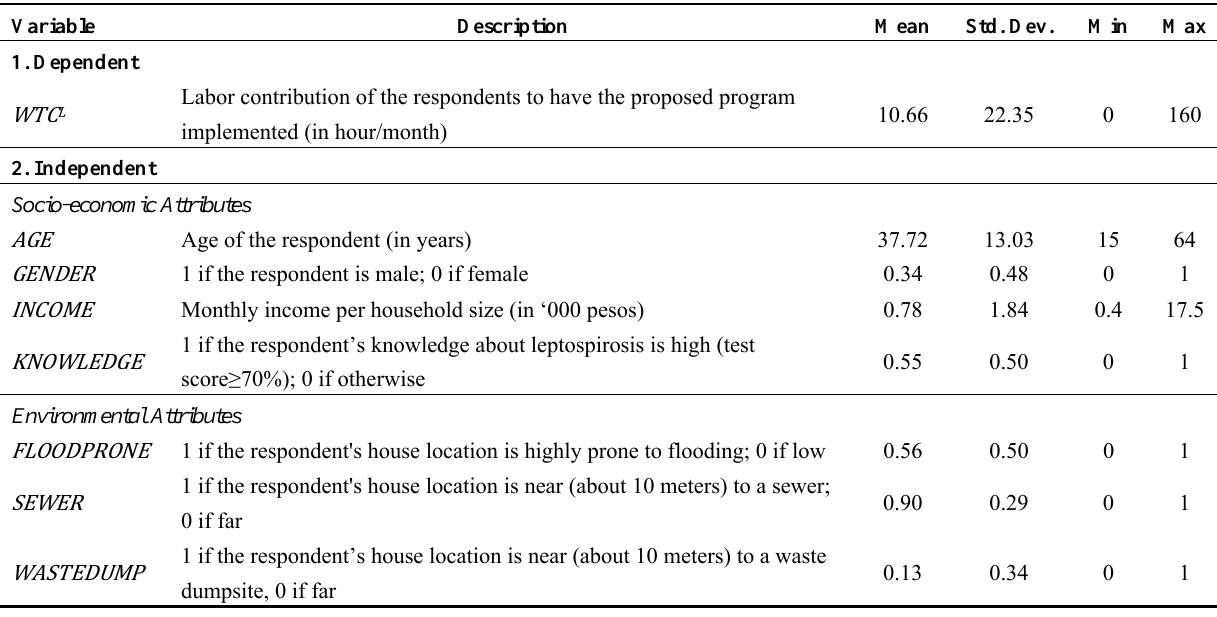
Table 1. Variable description and sample statistics (n =